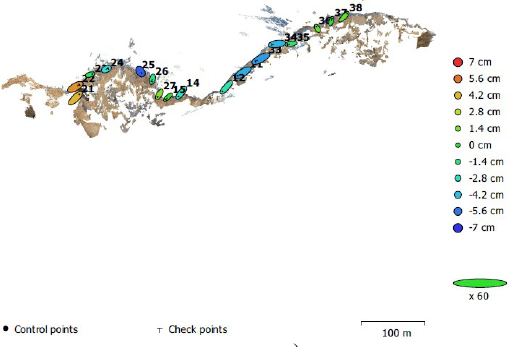
e) Figure 5. CP and ChP locations and error estimates. The errors on direction of Z axis are represented by ellipse color. The errors on direction of X and Y axis are represented by ellipse shape (XY plane). a) 3 CPs clustered on the north, b) 3 CPs clustered on the south, c) 3 CPs clustered on the middle, d) 3 CPs uniform, e) 8 CPs uniform